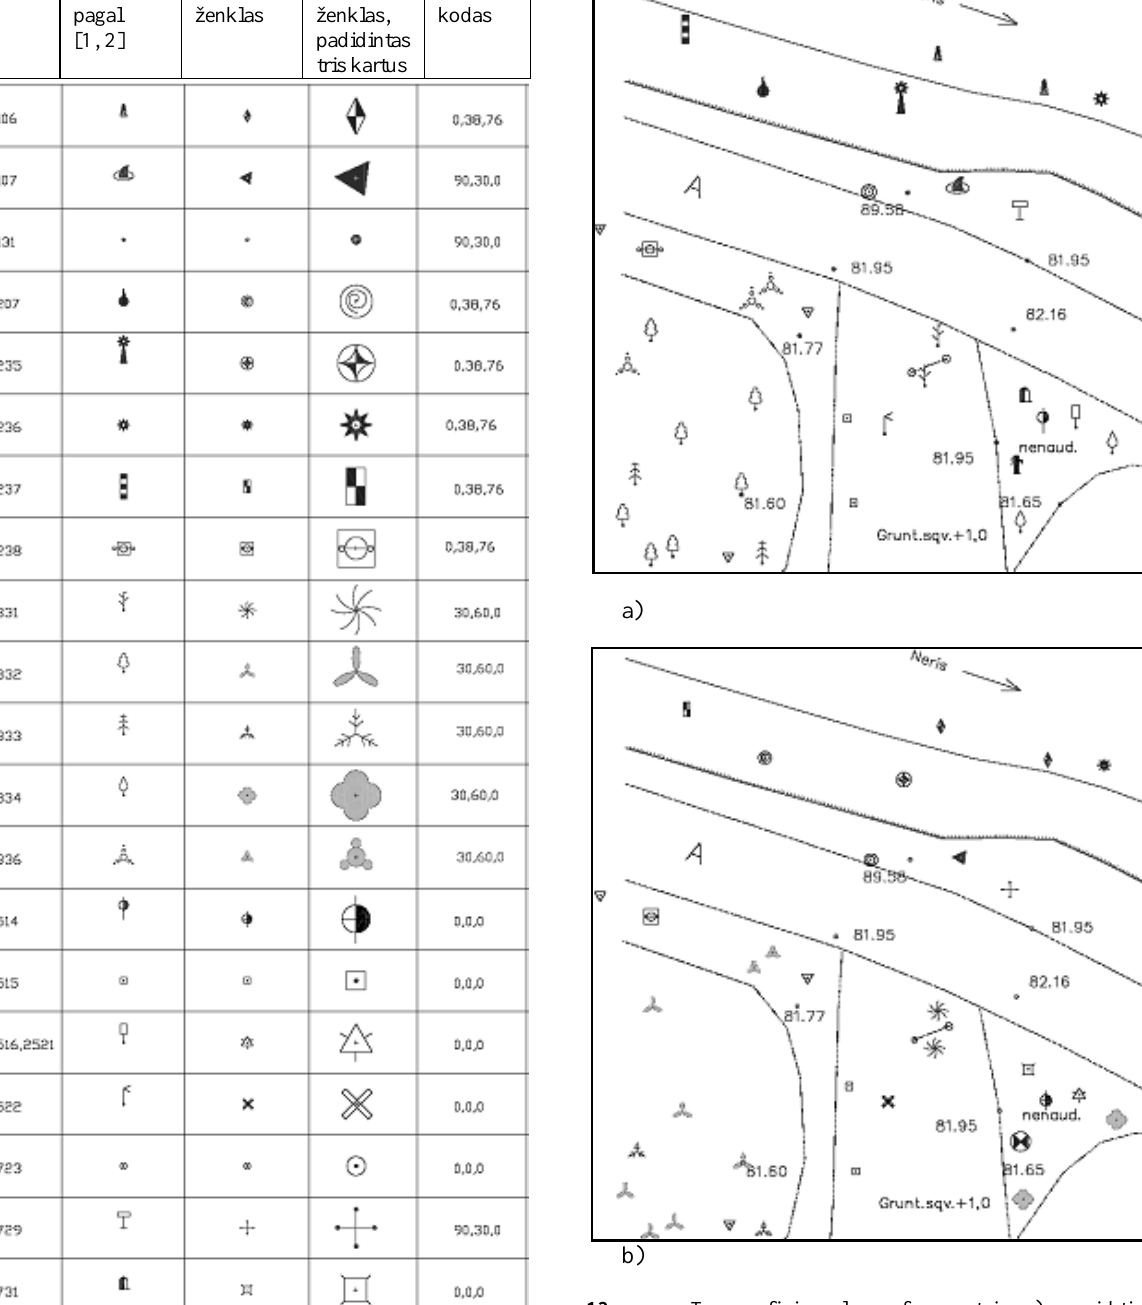
Fig 13 . Fragments of topographic plan: (a) with projected topographic signs [1, 2], (b) with suggested topographic signs 4. Išvados 1. Suformuluoti skaitmenini ų topografini ų sutartini ų ženkl ų konstravimo kriterijai. Tai asociatyvumas, proporcingumas, ekonomiškumas, paprastumas, susietumas, informatyvumas, atramos taško aiškumas; ryškumas; ribos aiškumas; simetriškumas, spalvingumas ir